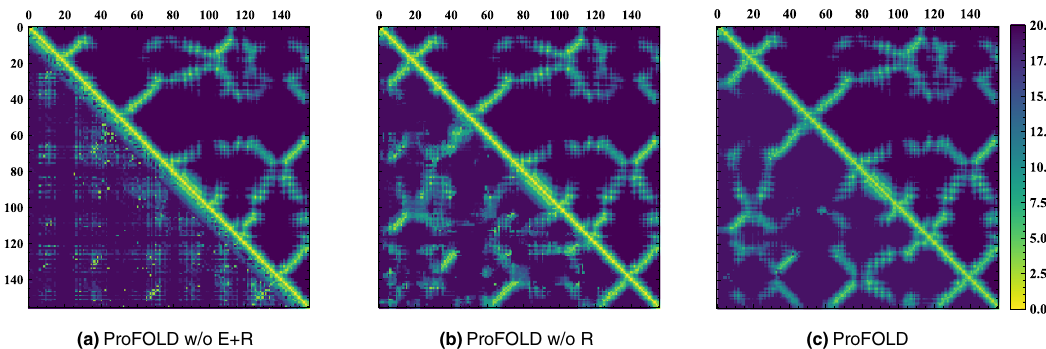
Fig. 7 Comparison of the predicted inter-residue distances (bottom left) with the ground-truth distances (upper right) for protein T1022s1-D1. a ProFOLD w/o E + R performed poorly and failed to generate high-quality distance estimations. b When equipped with the MSA encoder module, the variant ProFOLD w/o R could generate relatively accurate distance estimations. c When both MSA encoder and 2D ResNet are used, ProFOLD gave distance estimations extremely close to the real